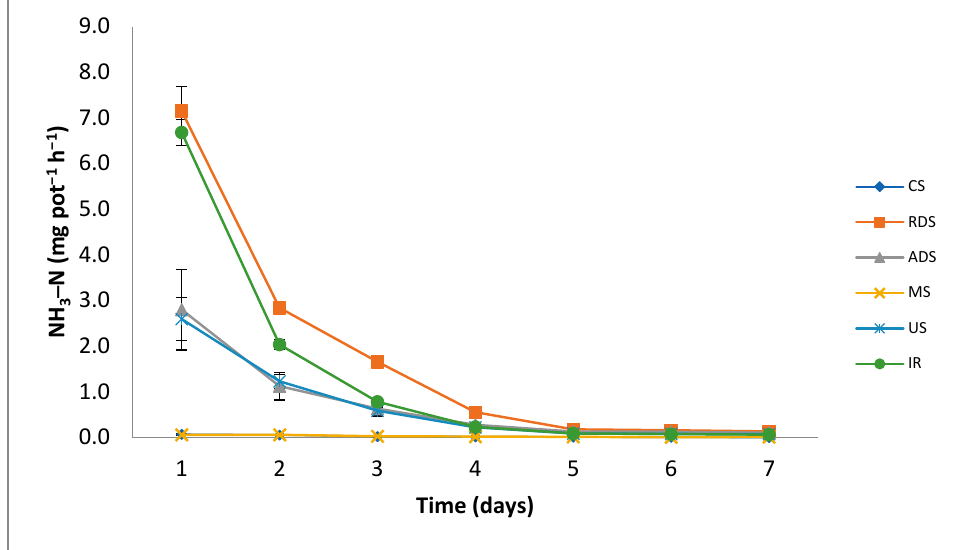
Figure 1. Daily ammonia emission rates (mg NH 3 –N pot − 1 h − 1 ). Vertical bars represent the standard error of the mean (mean, n = 3). Unfertilized stubble-covered soil (CS), raw dairy slurry on the stubble (RDS), acidified dairy slurry on the stubble (ADS), irrigation immediately after RDS (IR), mineral nitrogen on the stubble (MS), raw dairy slurry applied under the stubble